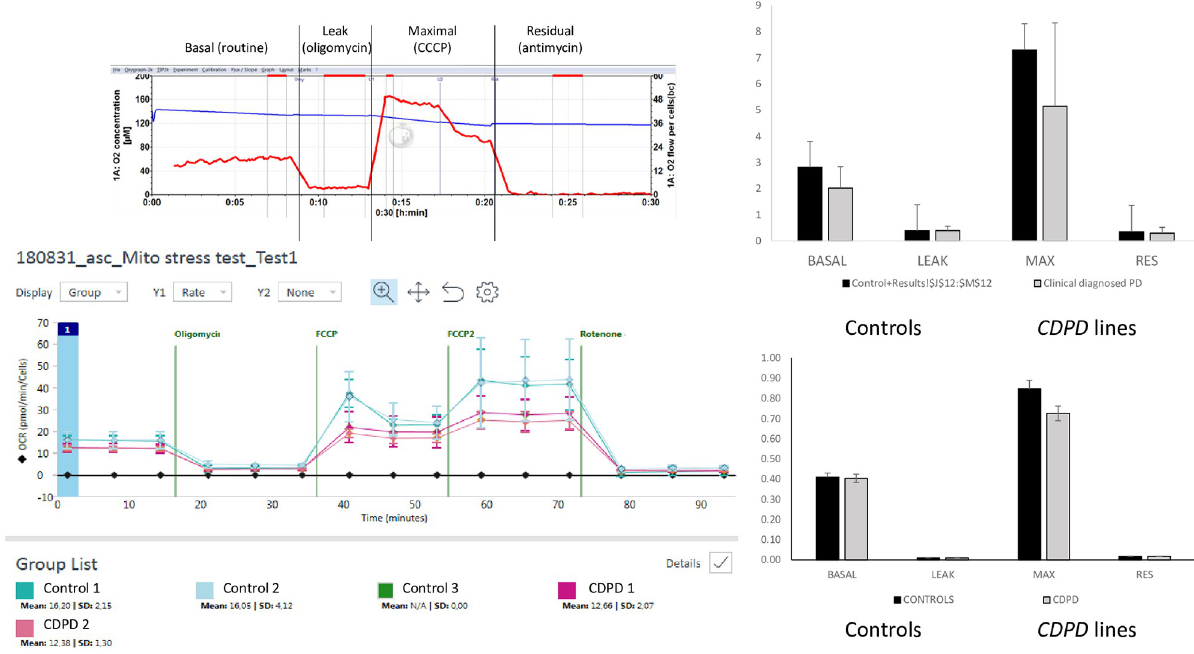
Fig 5. Bioenergetics profile through high-resolution respirometry. Upper graph, representative respiration OXPHOS slope states by Oroboros 2k- Oxygraph. Substrate and coupling states are shown. The blue curve indicates the O2 concentration in the O2k chamber, and oxygen fluxes per chamber volume are depicted (red curve) for the O2k chamber operated simultaneously. The upper horizontal bar denotes the respiratory states (routine, OXPHOS, leak and electron transport system states). Second graph, respirometry assessment and quantification of healthy control hASCs vs. CDPD hASCs. Basal or routine respiration of intact cells without any substrates or inhibitors, proton leakage after oligomycin inhibitor of ATP synthase or complex V, maximal respiratory capacity after CCCP uncoupler addition and final residual respiration after antimycin inhibition of the mitochondrial respiratory chain (specific inhibition of complex III). Basal oxidative respiration of intact cells tended to decrease respiration levels in the CDPD cases (p = 0.1). Third graph, representative respiration slope states by Seahorse X24 Agilent technology. Substrate and coupling states are shown in triplicate simultaneously through the 24-well system. Bottom graph, respirometry assessment and quantification of healthy control hASCs vs. CDPD hASCs. The same profile of basal respiration, proton leakage after oligomycin inhibition, maximal respiratory capacity after FCCP uncoupler titration and final residual respiration after rotenone-antimycin inhibition of the mitochondrial respiratory chain (specific inhibition of complexes I and III, respectively) is shown. Basal Respiration was calculated as (Basal-Rote/AA), Maximal Respiration was calculated as (FCCP-Rote/AA). For both Oroboros and Seahorse technologies, trends toward lower maximal respiration capacity were observed in PD hASCs. hASC, human adipose stem cells, CDPD , clinically diagnosed Parkinson’s disease; Max, maximal; Res,